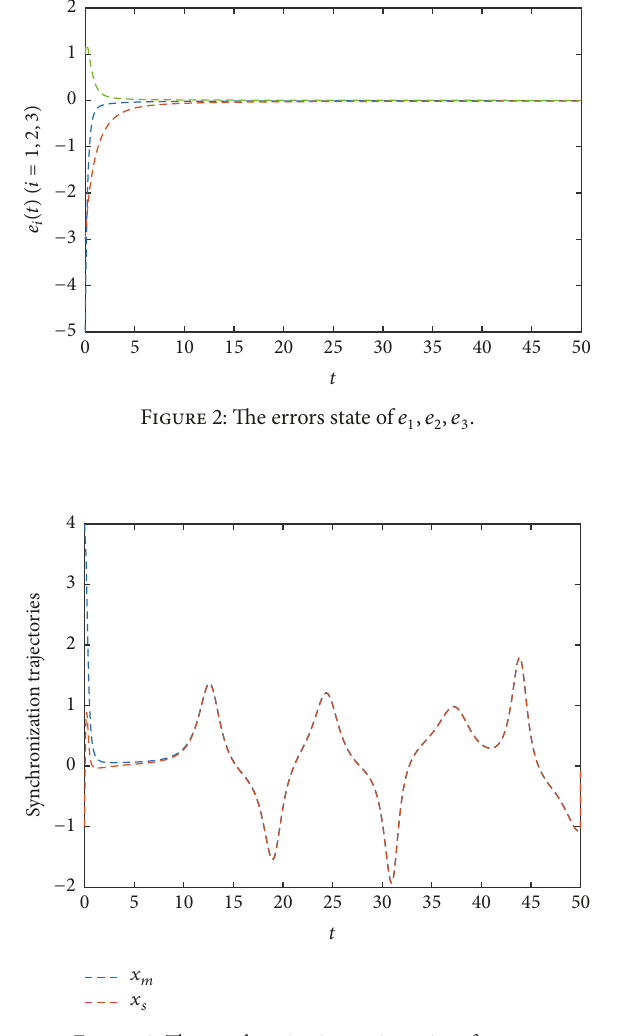
Figure 3: The synchronization trajectories of 𝑥 𝑚 , 𝑥 𝑠 .